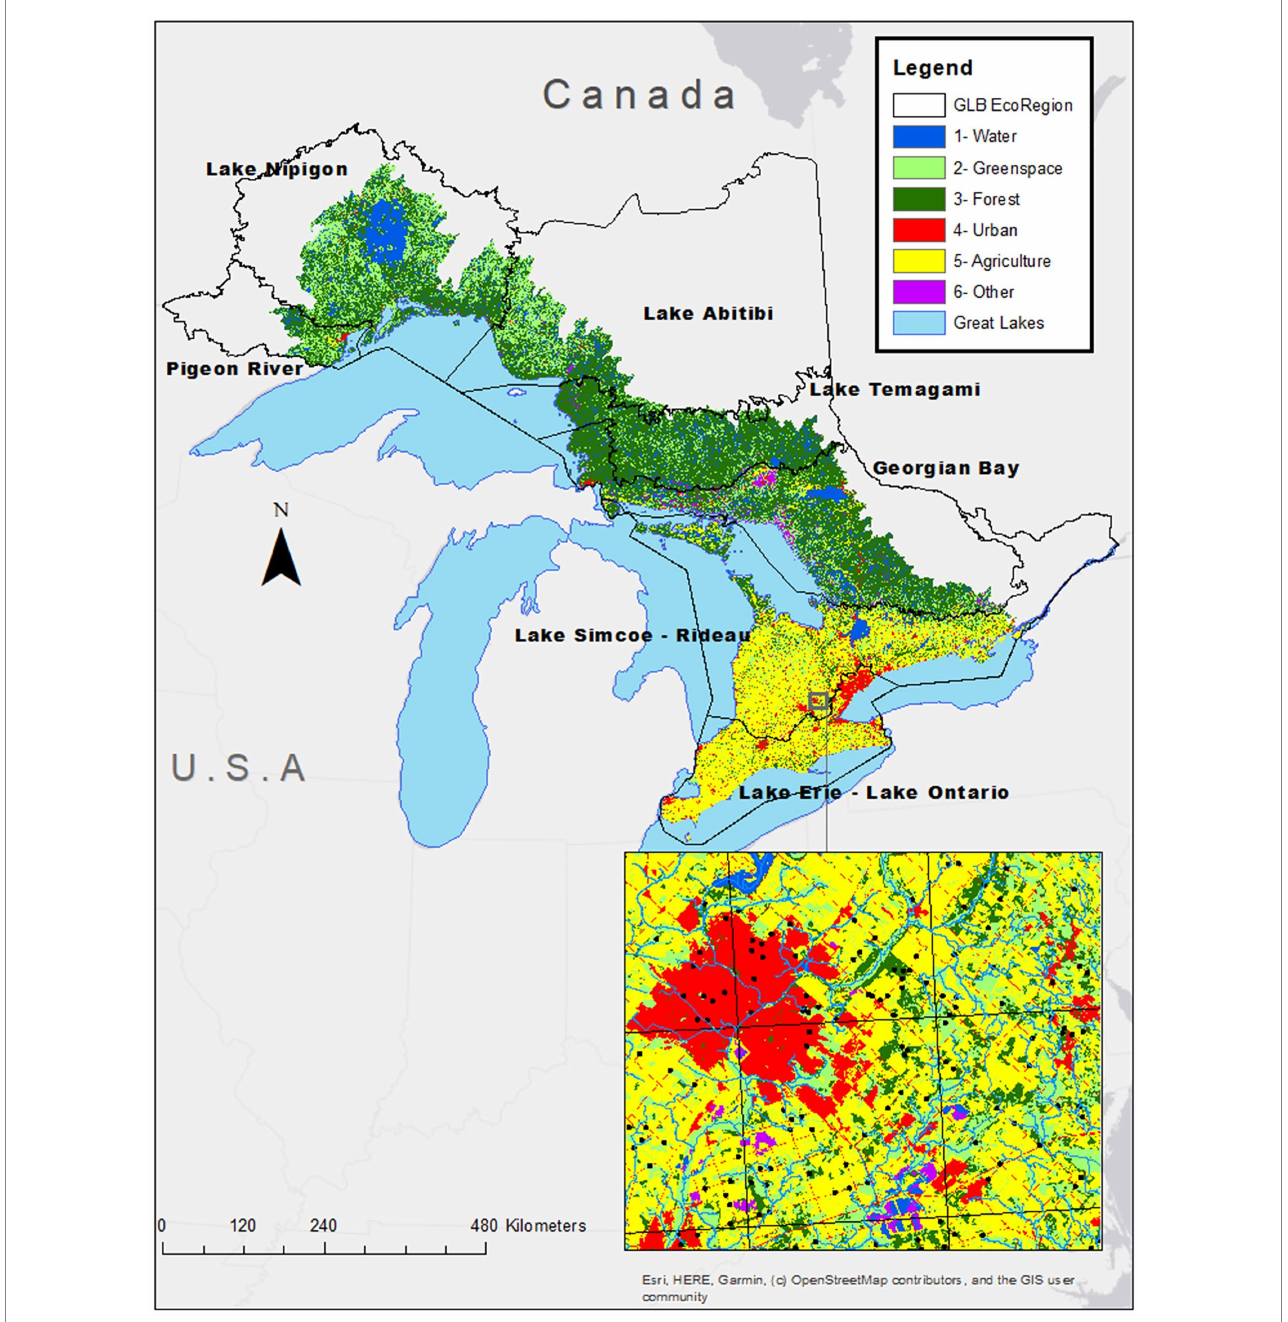
FIGURE 1 Map of study area (Canadian side of the Great Lakes Basin) showing landcover types and location of the Ecoregions. The inset map shows a few of the OBBA sampling locations. Pixel resolution is 15